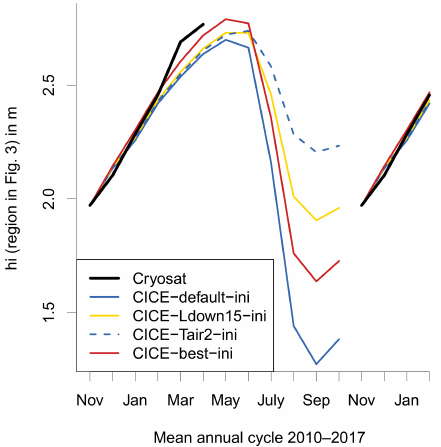
Figure 5. Impact of uncertainty in atmospheric forcing on simulated mean effective sea ice thickness over the region shown in Fig. 3 and averaged over winter periods 2010/11 to 2016/17. CICE-ini simula- tions: default, default with increase of incoming longwave radiation of 15Wm − 2 , default with increase of 2m air temperature of 2K (everywhere and anytime), and best. Model results are compared with mean sea ice thickness from CS2